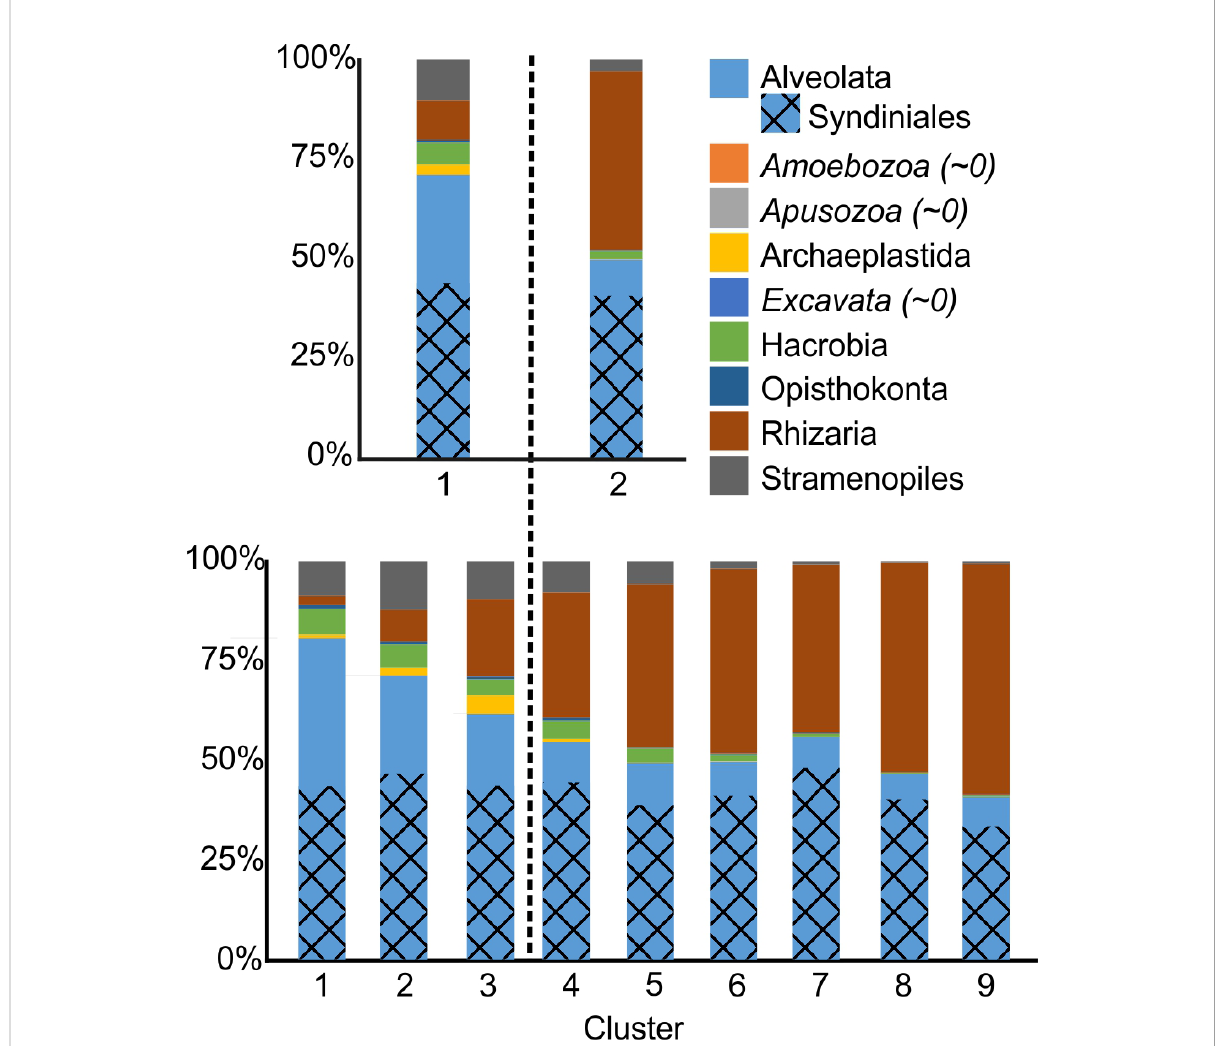
FIGURE 4 Taxonomic composition (at clade level) for each non-hierarchical cluster at K =2 (top) and K =9 (bottom). The parasitic order Syndiniales is highlighted within the Alveolata, showing its dominance within this phylum. Dashed line approximate the divide between the epi (left) and the mesopelagic